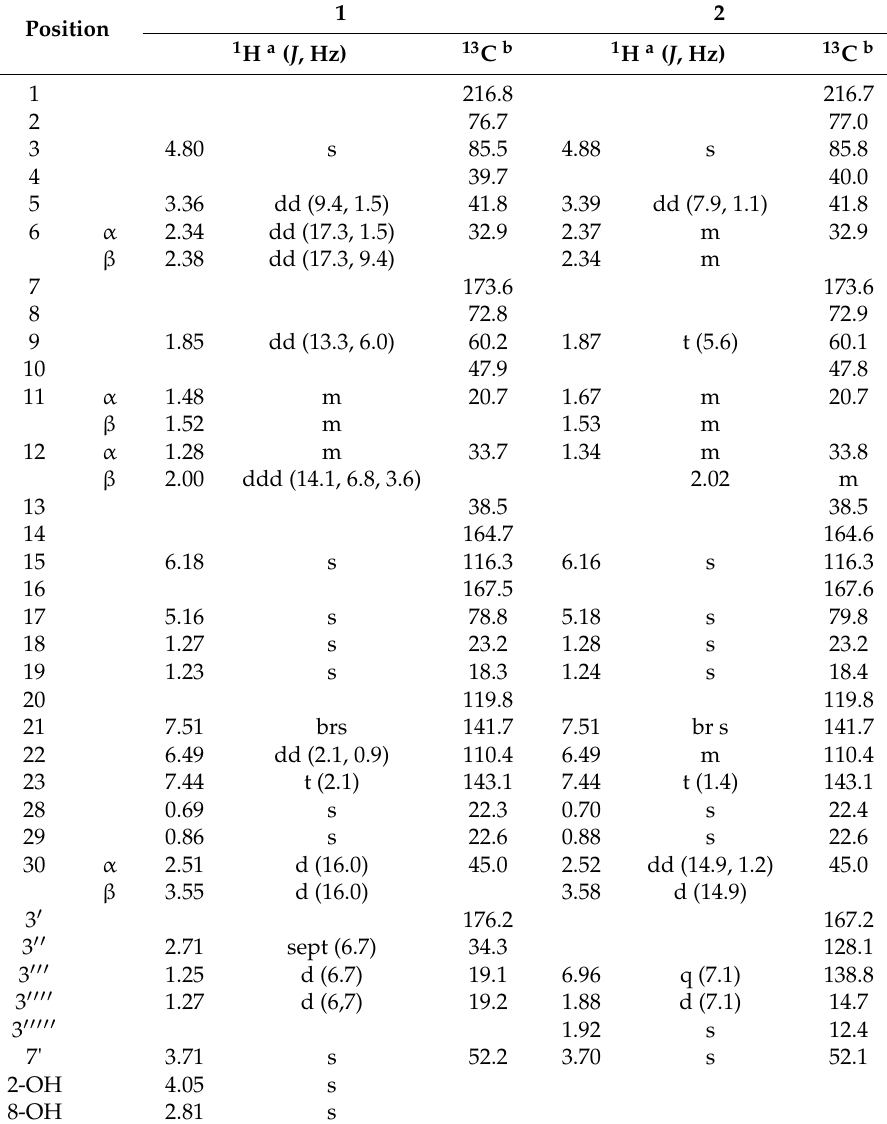
Table 1. 1 H- (600 MHz) and 13 C- (150 MHz) NMR spectroscopic data of compounds 1 and 2